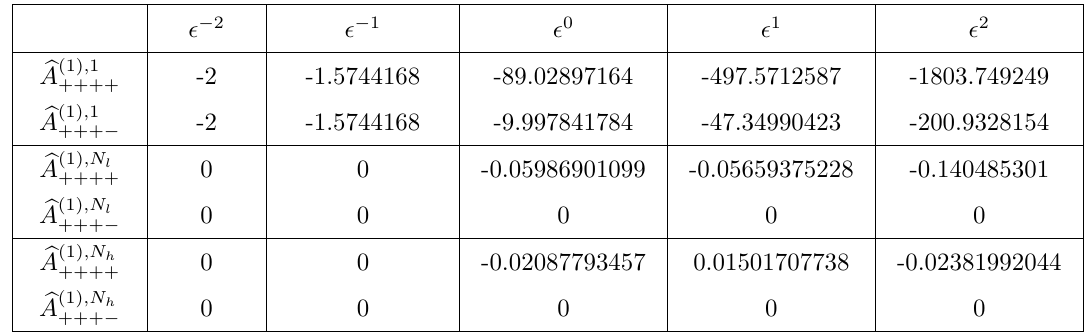
Table 2. Mass renormalised one-loop amplitudes (normalised to the tree level amplitude) using the kinematic point in eq.